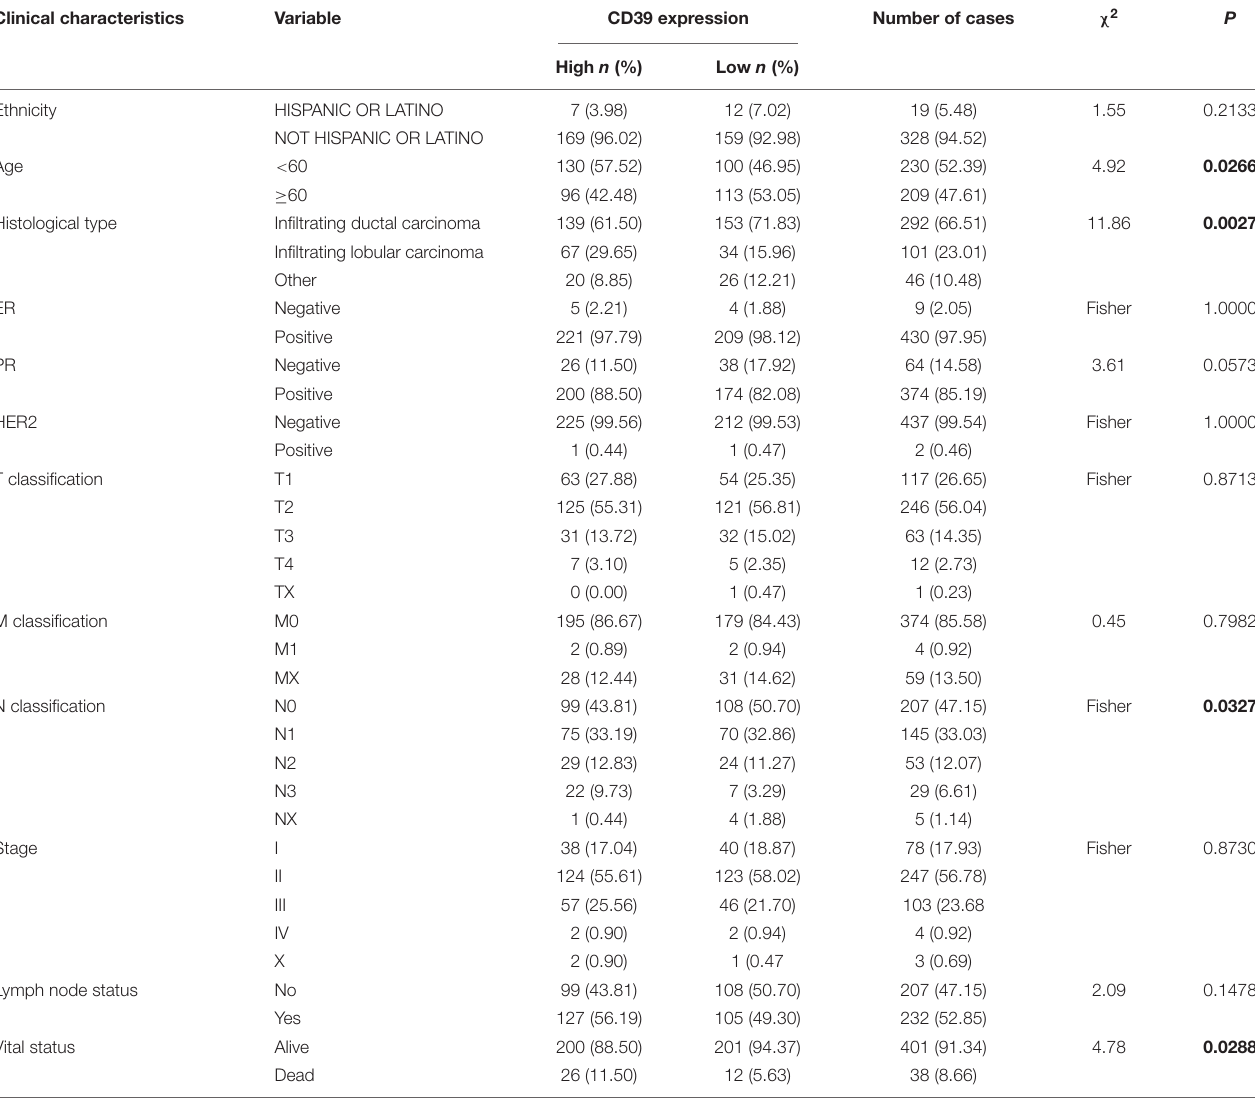
TABLE 2 | Correlations of CD39 expression in luminal BC tissues with clinicopathologic features. Clinical characteristics